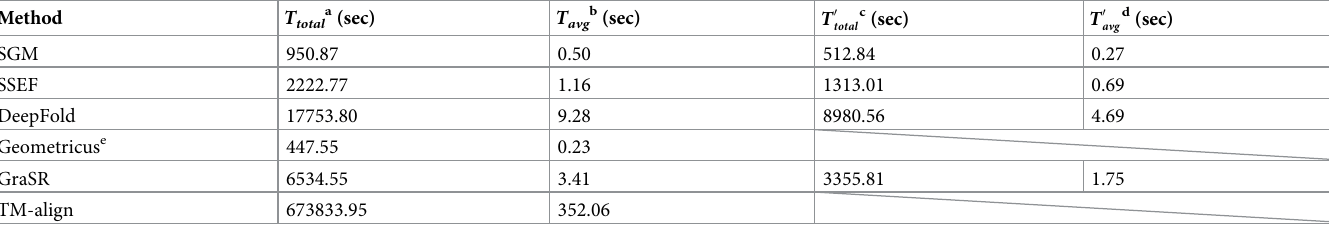
Table 4. Time cost of GraSR and other methods for protein structure retrieval from